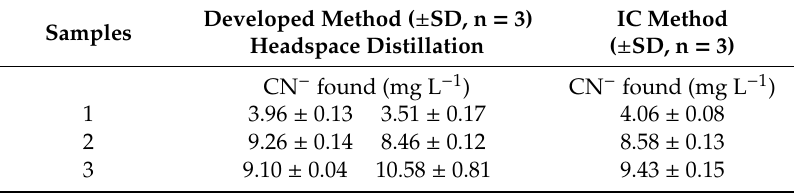
Table 1. Determination of CN − in metallurgical industry wastewater samples.